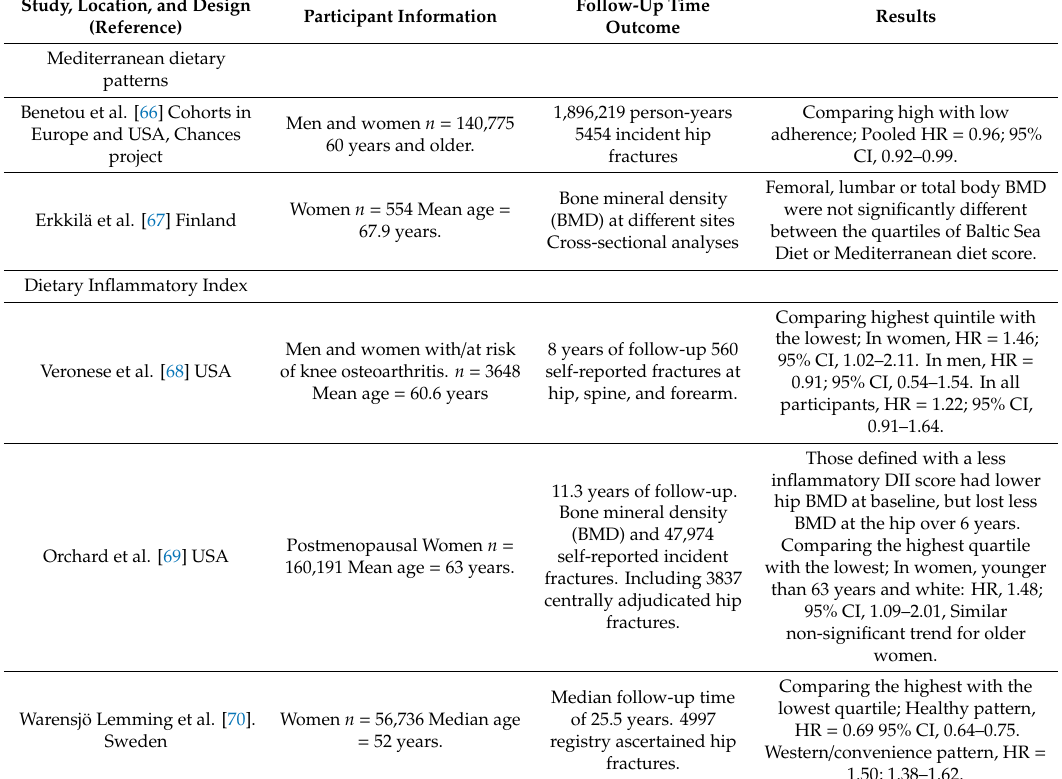
Table 1. Depicted is the study characteristics of the seven studies published after April 2016 with relevance for the present narrative